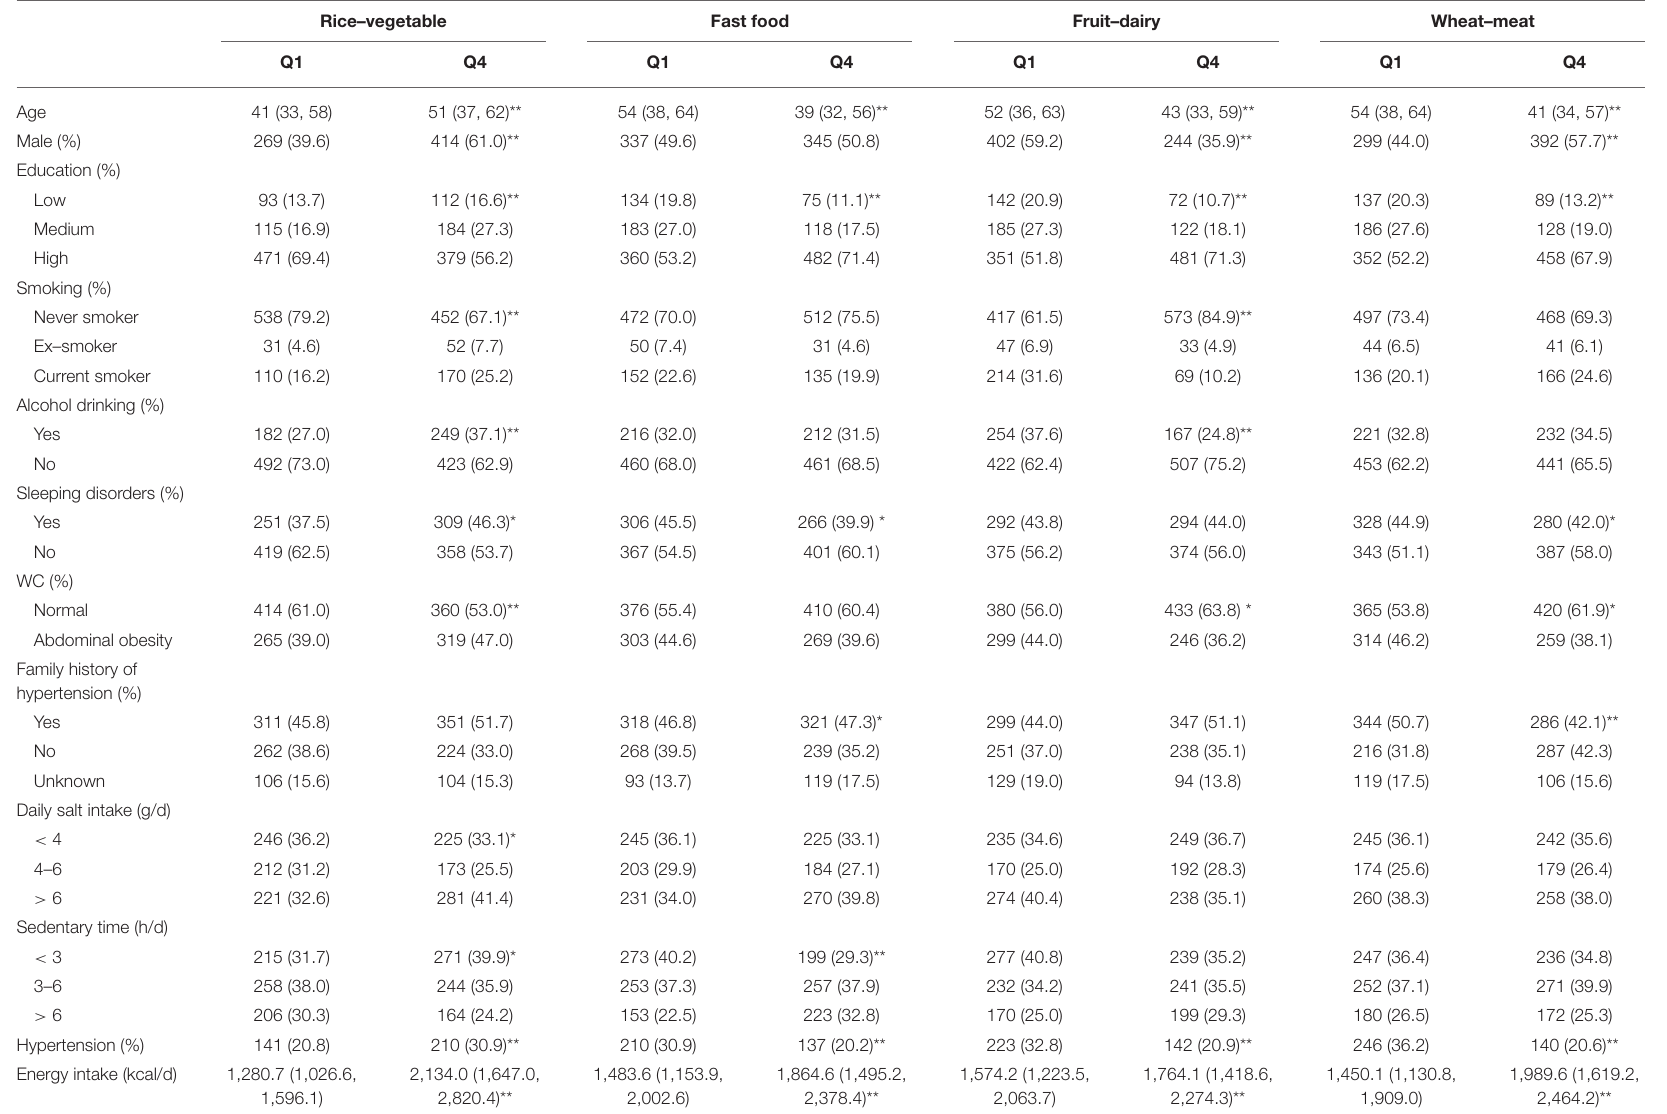
TABLE 3 | Sociodemographic, lifestyle, and anthropometric characteristics of the study participants across quartiles of the dietary patterns scores ( n =